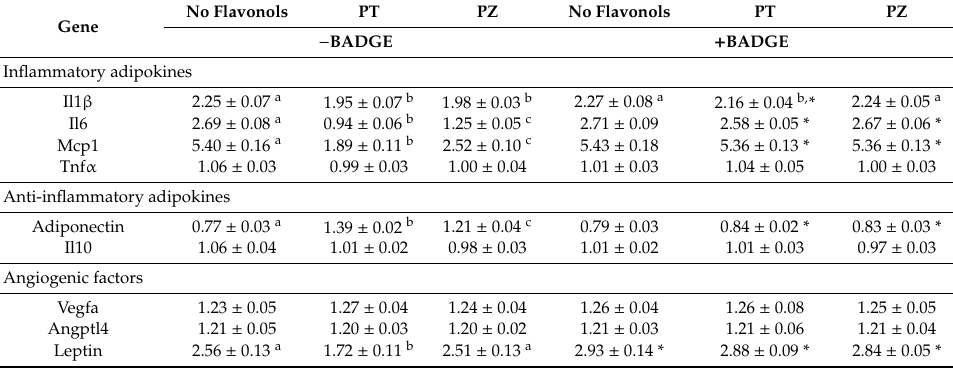
Table 1. mRNA expression in lipopolysaccharide (LPS)-stimulated adipocytes treated with phloretin (PT) or phlorizin (PZ), with and without bisphenol A diglycidyl ether (BADGE) 1